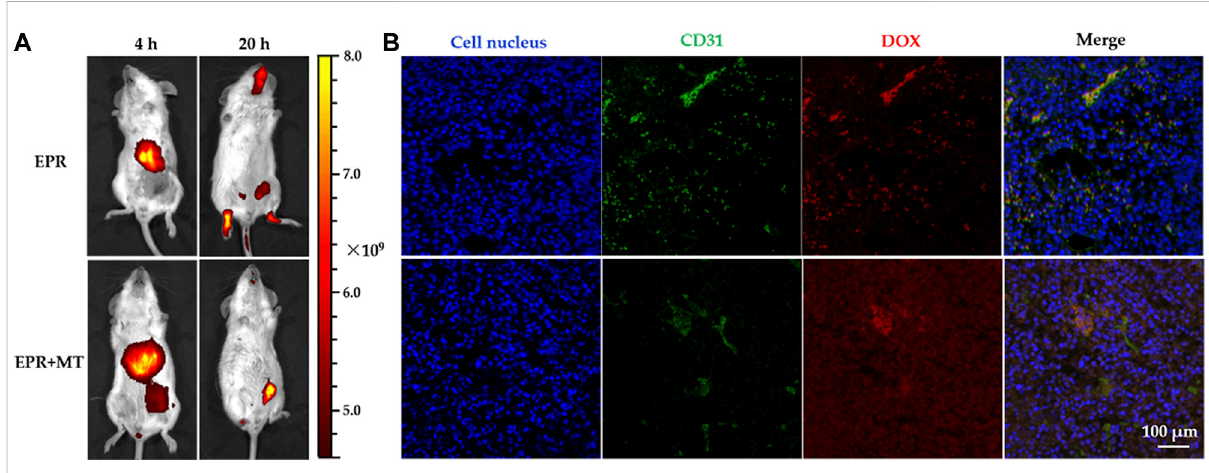
FIGURE 8 Near-infrared (NIR) in vivo imaging of tumor-bearing mice after injection of doxorubicin-loaded magnetothermally-sensitive micelle modi fi ed by Cy7 (DOX – MTM – Cy7) and DOX distribution in tumor after magnetic hyperthermia (MH) of 20 min: (A) Distribution of DOX – MTM – Cy7 in tumor- bearing mice after different targeting strategies (EPR or EPR + MT) 4 and 20 h post-injection; (B) the intra-tumoral DOX distribution of different targeting approaches after MH (20 min, 114 kHz and 15.9 kA/m) at 20 h post-injection, with cell nuclei staining (DAPI, blue), tumor vessels staining (FITC,